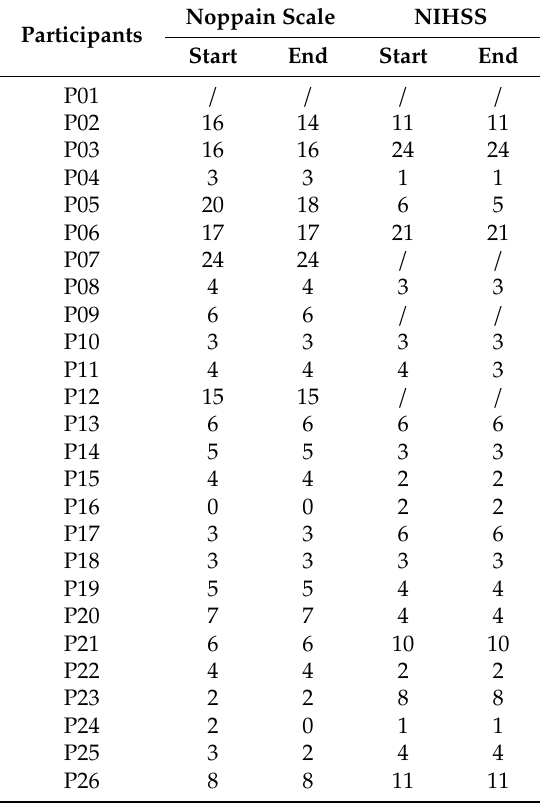
Table 4. Summary of all